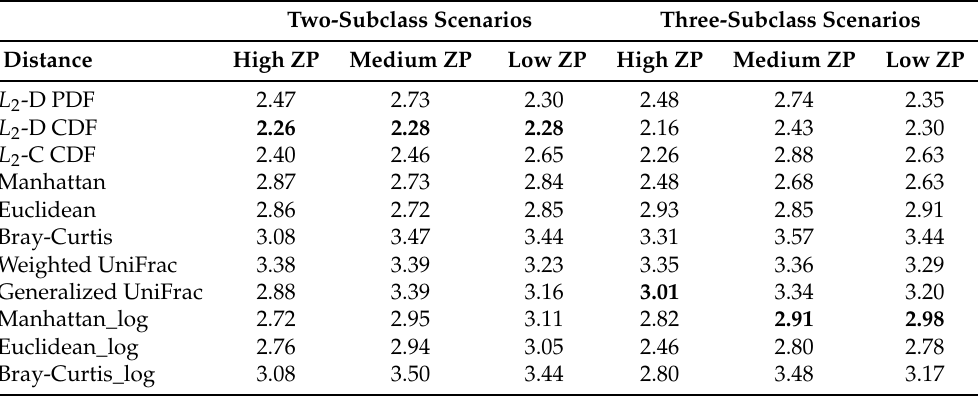
Table 2. Average number of clusters for all simulation scenarios. Optimal number of clusters in each replicate is calculated by Dunn internal indices. A bold value represents the closest estimation of number of clusters to the ground